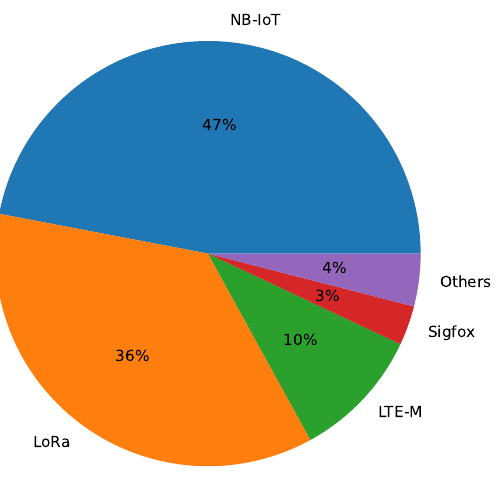
Figure 3. Technological distribution of installed LPWANs technologies base in